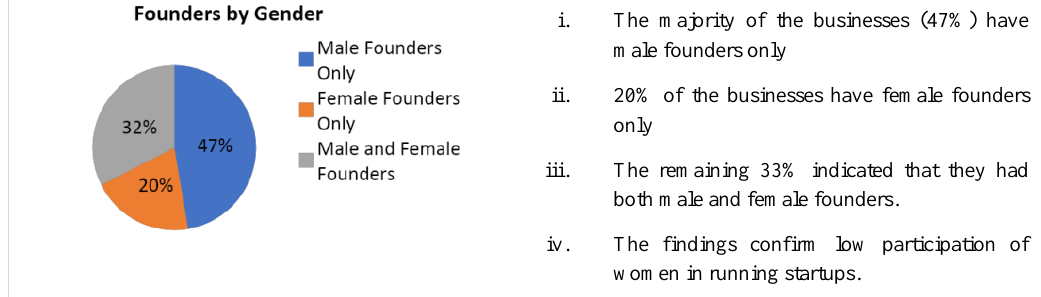
Figure 4: Gender of Startup